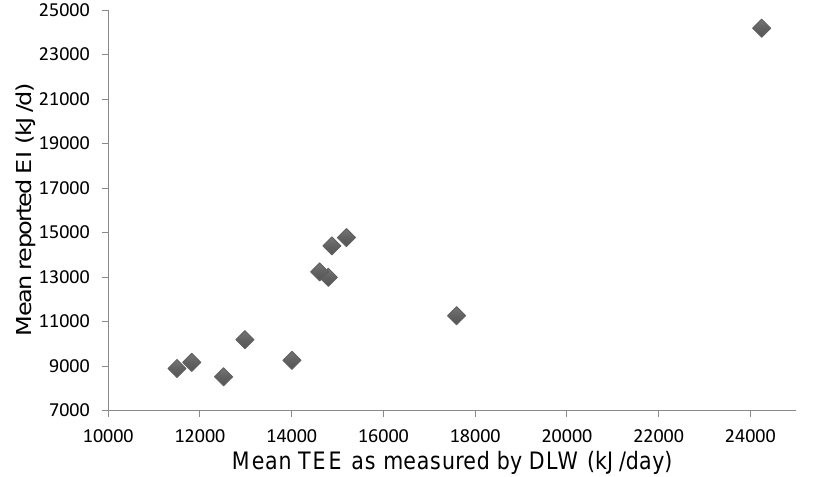
Figure 2. Mean reported energy intake (EI) when compared to mean energy expenditure (TEE) measured by doubly labelled water (DLW) (kJ/day).